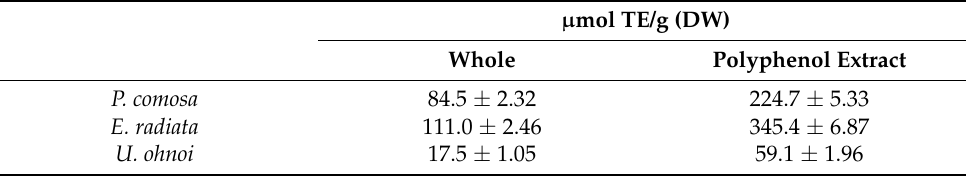
Table 5. Oxygen radical absorbance capacity of WH seaweeds and PP extracts (ORAC units µ mol TE/g DW ±